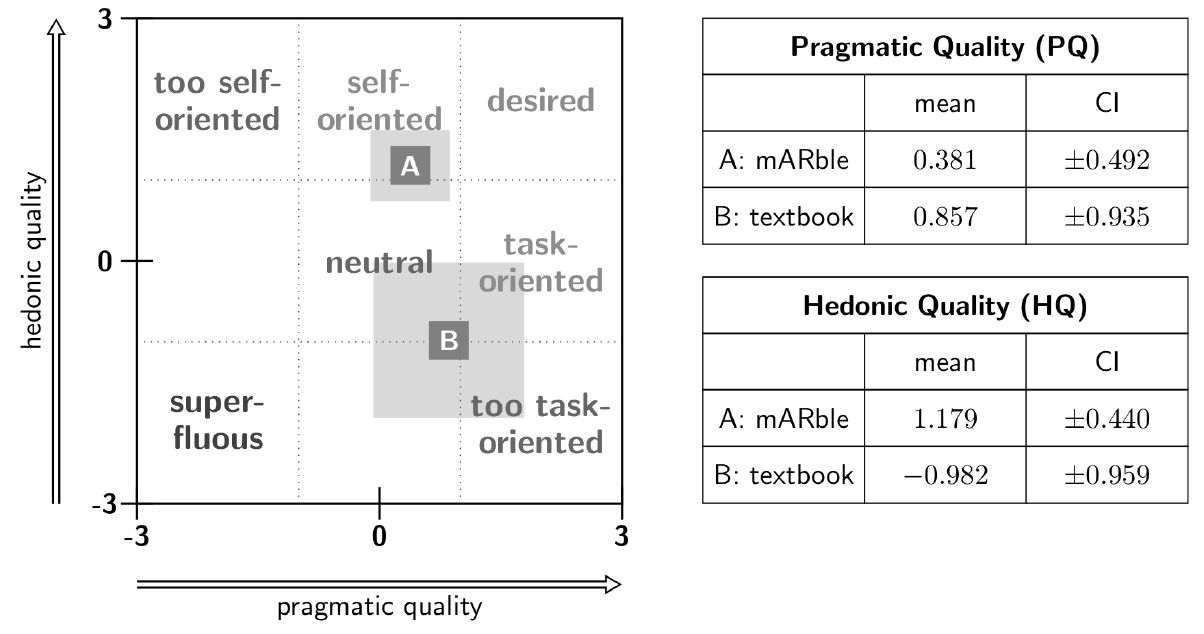
Figure 4. Portfolio with average values of the dimensions PQ and HQ and the respective confidence rectangles of A (mARble) and B (textbook) on left, modified following Hassenzahl et al; corresponding values on right.